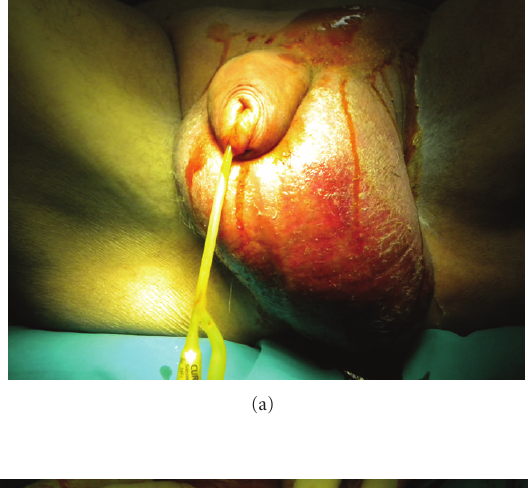
White blood cell count was 10000/ µ L, C-reactive protein (CRP) was 25 mg/dL, and blood glucose was 300 mg/dL.